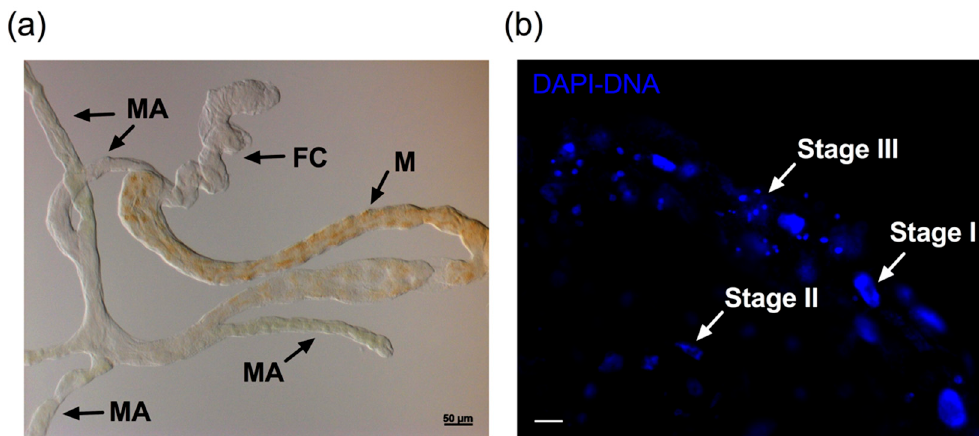
Figure 2. Nuclear architecture changes after ConA feeding. ( a ) Light micrograph of the potato psyllid alimentary canal showing characteristic structures. FC: filter chamber, M: midgut, MA: midgut appendages. ( b ) The nuclear morphology (blue, DAPI staining) in the gut of potato psyllids after feeding in sucrose diets containing ConA for 72 h. Stages I, II, and III represent the three stages of apoptotic nuclei changes. Scale bar is 20 μ m.